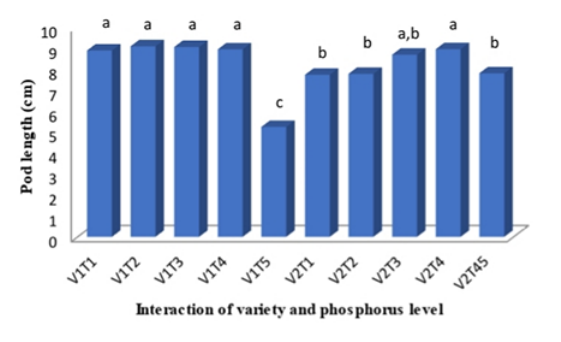
Figure 3 Interactive effect of varieties and different levels of phosphorus on the length of pods in